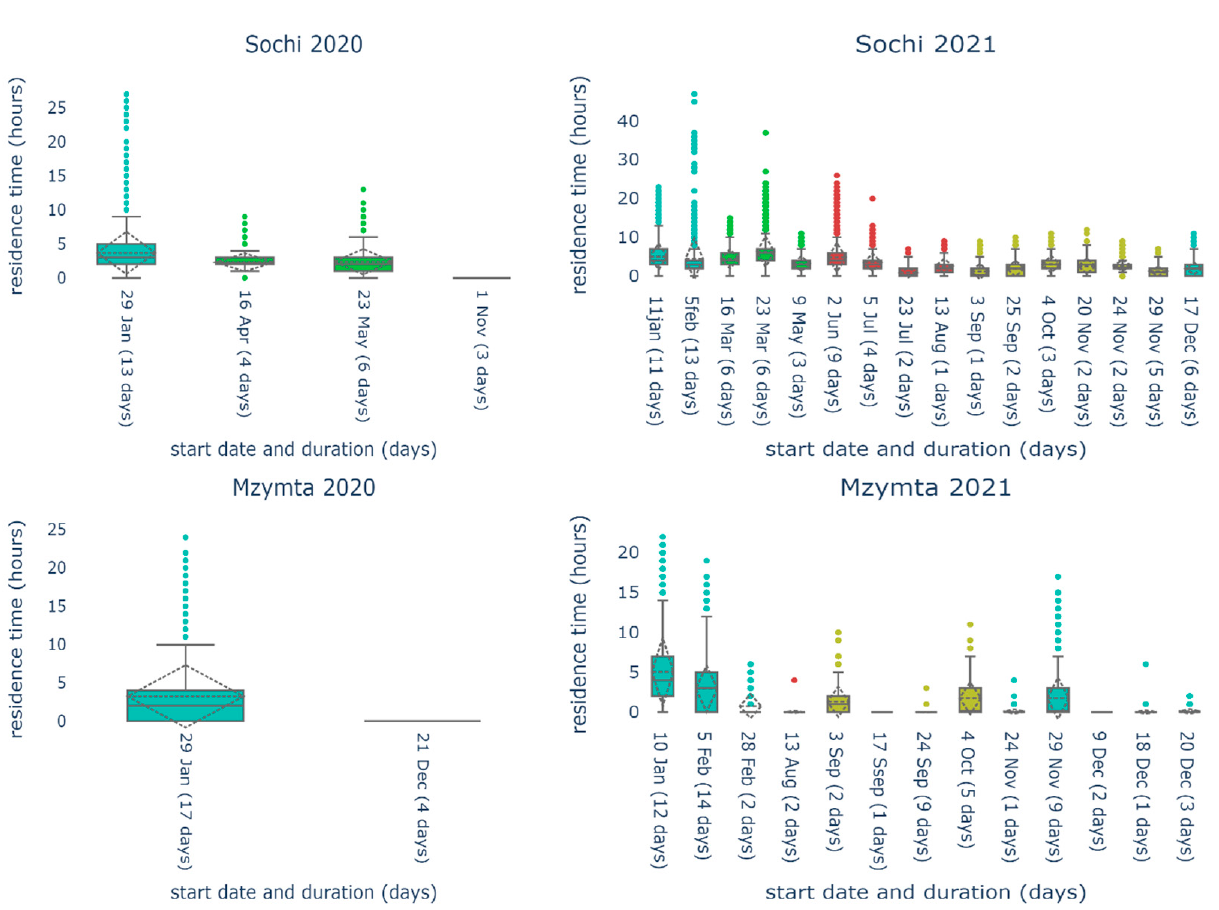
Figure 9. The freshwater residence time within the plumes (hours) for floods for low-discharge year (2020) ( left ) and the high-discharge year (2021) ( right ) on the Mzymta ( bottom ) and the Sochi ( top ) rivers. Box plots show the median, upper and lower quartiles, minimum and maximum values, and all outliers in the dataset. The dotted line shows the average value, and the color indicates the sea- sons of flood occurrence (turquoise—winter, green—spring, red—summer, yellow—autumn).